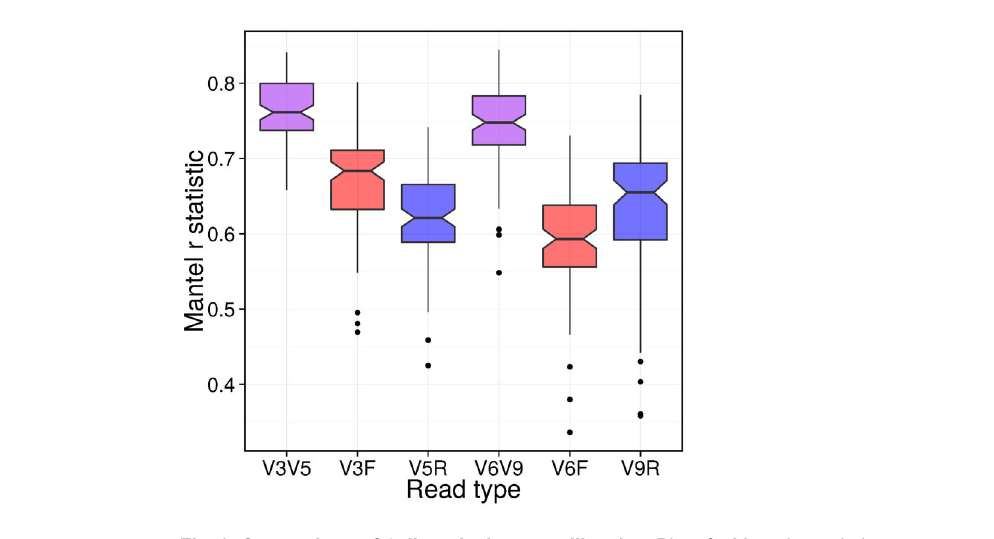
Fig. 3. Comparison of b -diversity between libraries. Plot of a Mantel correlation test comparing unweighted UniFrac distance matrices created using synthetic mock communities from paired, R1 and R2 reads (for both the V3–V5 and V6–V9 pairs) versus the distance matrix created from the corresponding full-length 16S synthetic mock communities. A higher correlation value means the distance matrices, and hence their b - diversity, are more closely related to the full-length communities. Here, the communities from paired reads are significantly closer to the full-length communities than the R1 and R2 communities ( p , 0.0001, Wilcoxon signed ranked test, using 100 synthetic mock communities), strongly suggesting that combining the use of paired reads leads to results closer to what is obtained from full-length reads, even when the chosen primers create non-overlapping